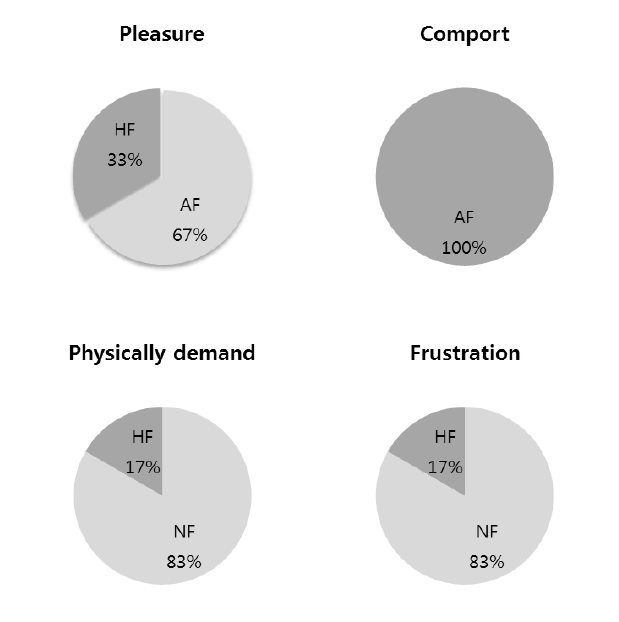
Figure 23. Participants’ preferences about feedback